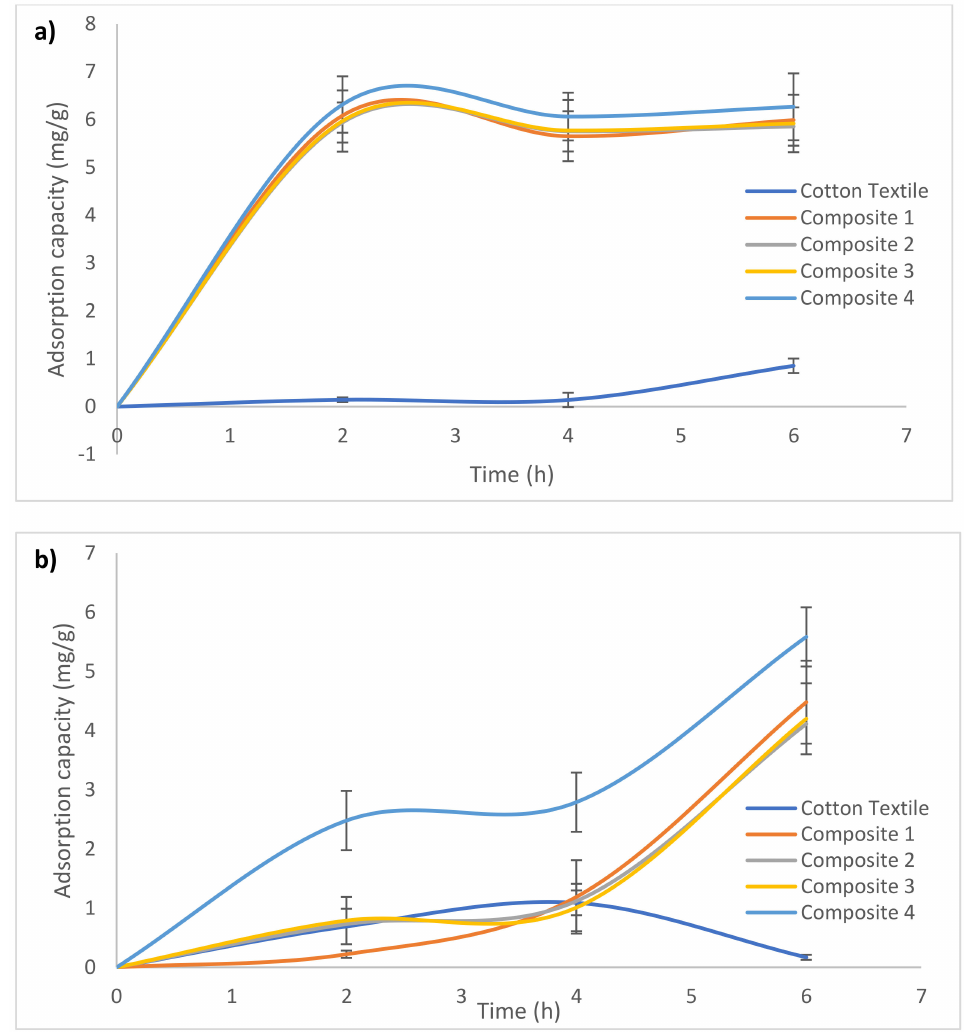
Figure 6. Adsorption capacity of composites and cotton textiles in ( a ) PbO solution or ( b ) Pb(NO 3 ) 2 solution, both at pH